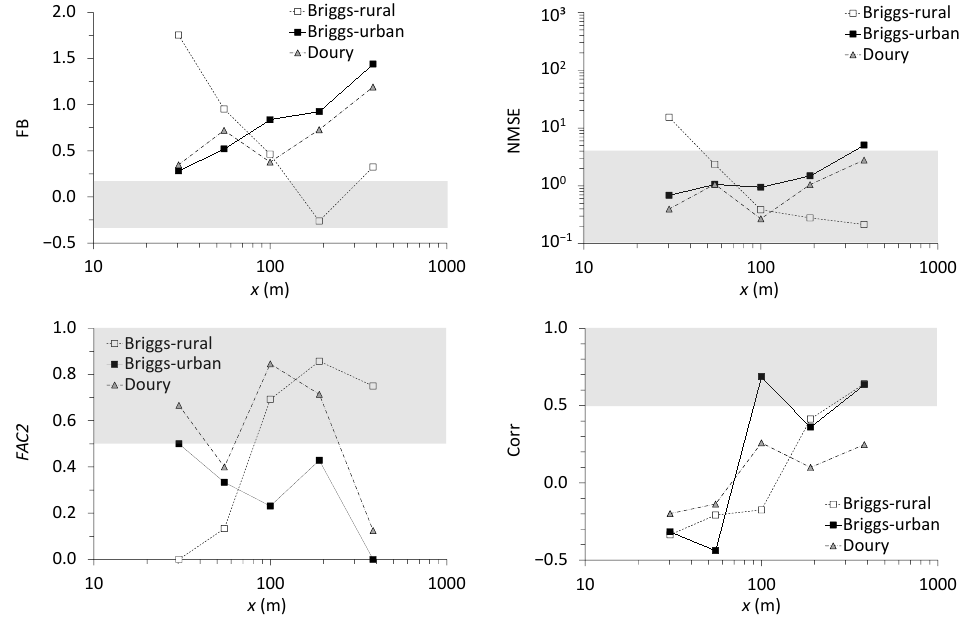
Figure 7. Ratio between the maximum atmospheric transfer coefficients ATCmax p predicted by the Briggs-rural, Briggs-urban and Doury Gaussian models and ATCmax o measured as a function of distance x from the discharge point.